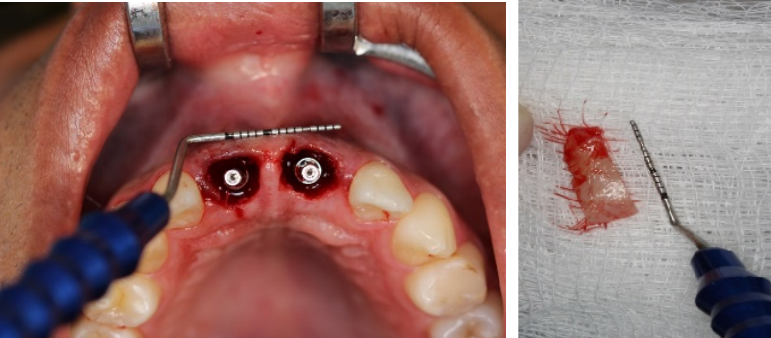
Figure 8. Measurement and removal of the connective tissue fragment.